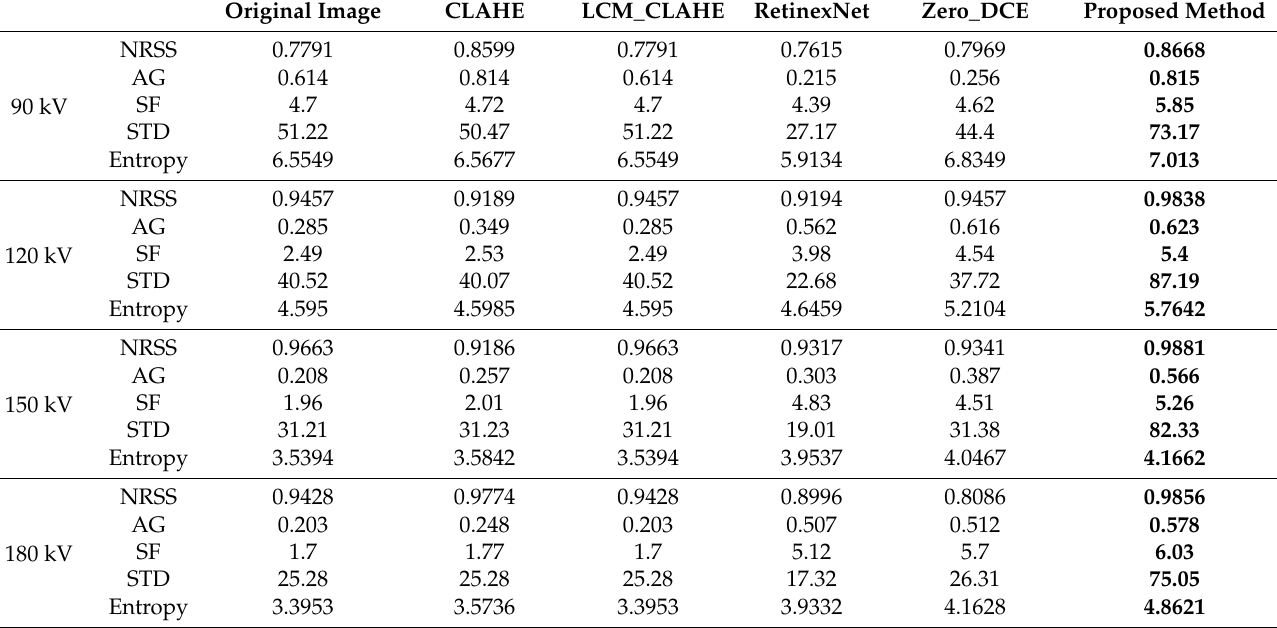
Table 2. Evaluation indicators of different methods.